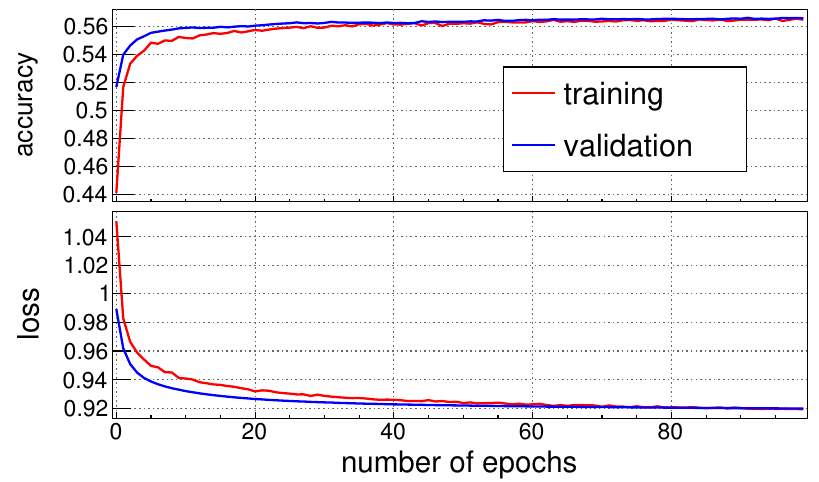
Figure 17 . Training curves of the neural network training, displaying the evolution of the accuracy (top) and value of the loss function (bottom) for increasing number of epochs. These curves are shown both for the training (red) and for an independent validation data set (blue). These curves converge towards each other and reach a plateau after about 100